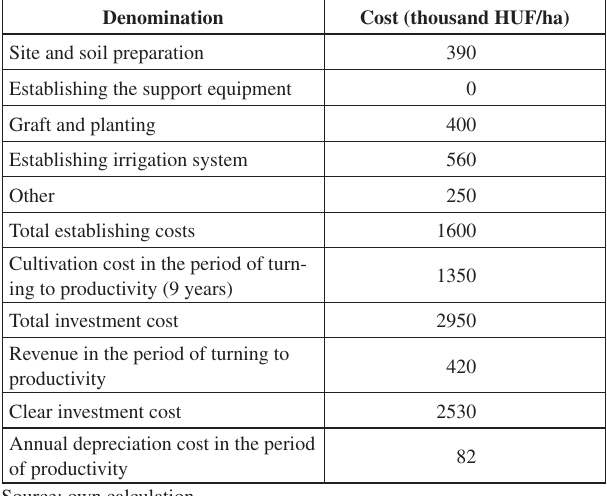
Table 1: The investment cost of the characterized walnut orchard